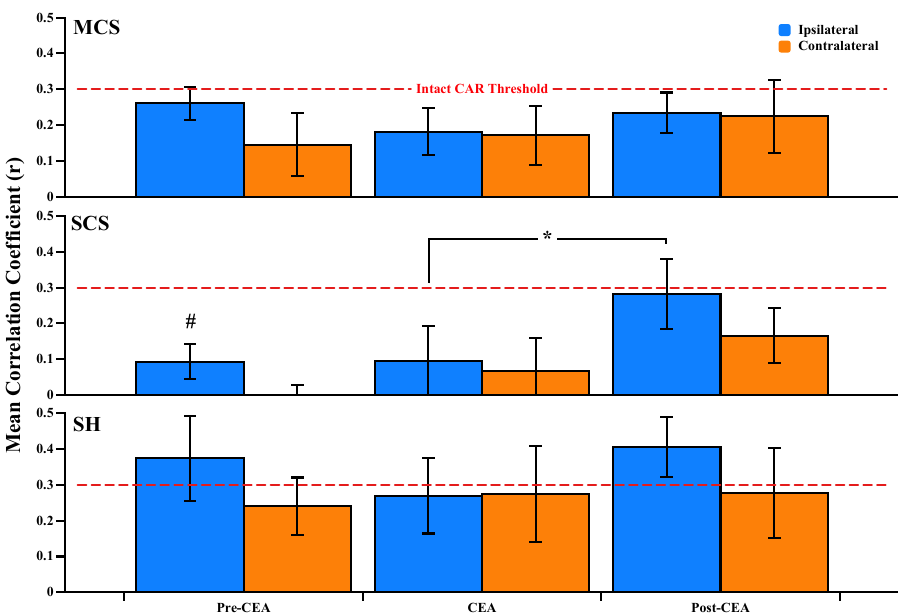
Figure 6. Mean correlation coefficients ( r ) between CBF i and MAP during pre-CEA, CEA, and post-CEA phases in the MCS, SCS, and SH groups. The ipsilateral hemisphere is blue, and the contralateral hemisphere is represented in orange color. CBF i was more autoregulated in the SCS group than MCS and SH groups during the pre-CEA phase (indicated as #, p = 0.003). The intact CAR threshold ( r = 0.3) is indicated as a red dashed line. Data are shown as mean ± standard error of the mean. * p = 0.03. CAR, cerebral autoregulation; CBF i , cerebral blood flow index; MAP, mean arterial pressure; CEA, carotid endarterectomy; MCS, mild contralateral stenosis group (<50%); SCS, substantial contralateral stenosis group (≥50%); SH, shunt group.